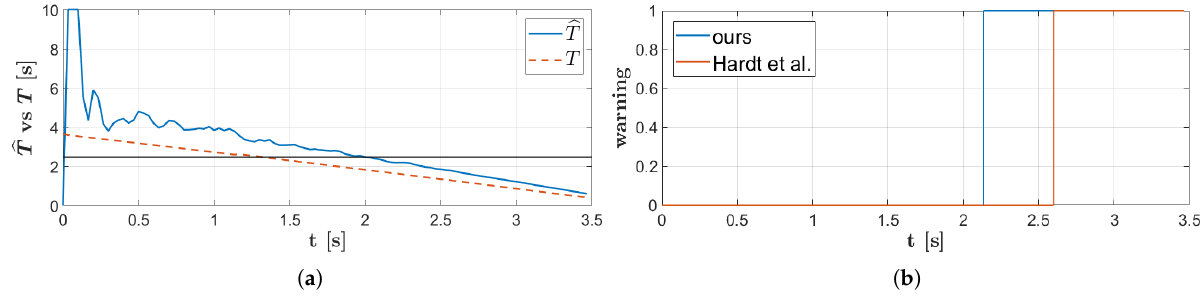
Figure 4. Simulation results, through MIL testing, in the CCRM scenario. ( a ) Time-history of the estimated Time-To-Collision, (cid:98) T , and of the real one, T . The warning threshold is shown as constant horizontal line ( b ) Time-history of the Forward Collision Warning